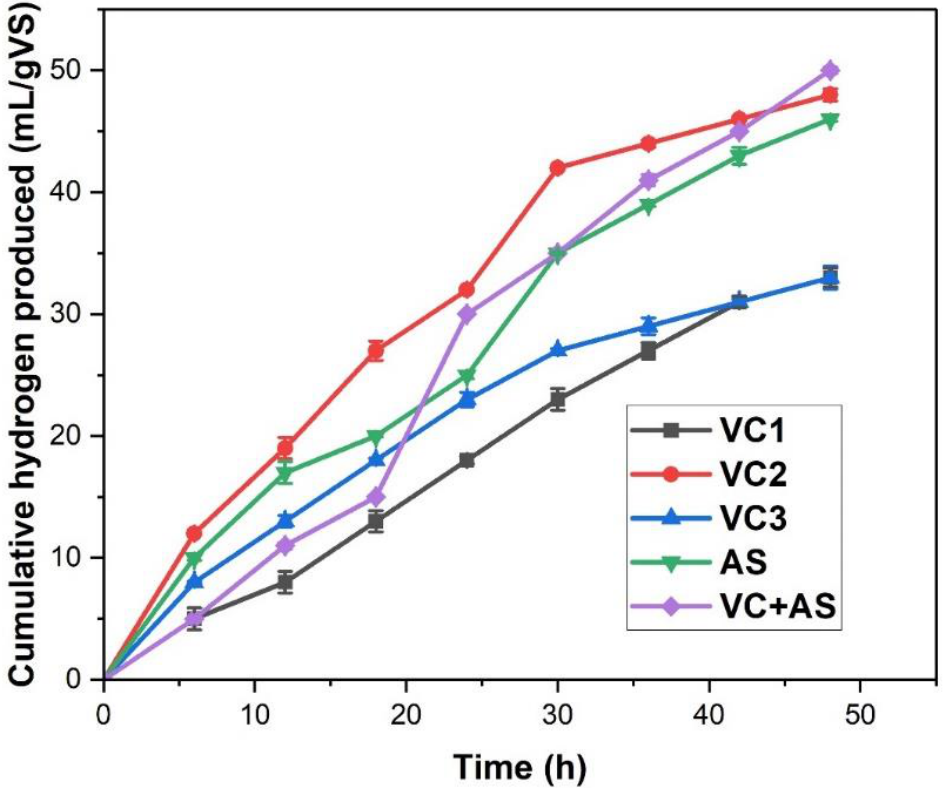
Figure 4. Cumulative hydrogen produced in different reactors (VC1, VC2, VC3, AS, and VC+AS).